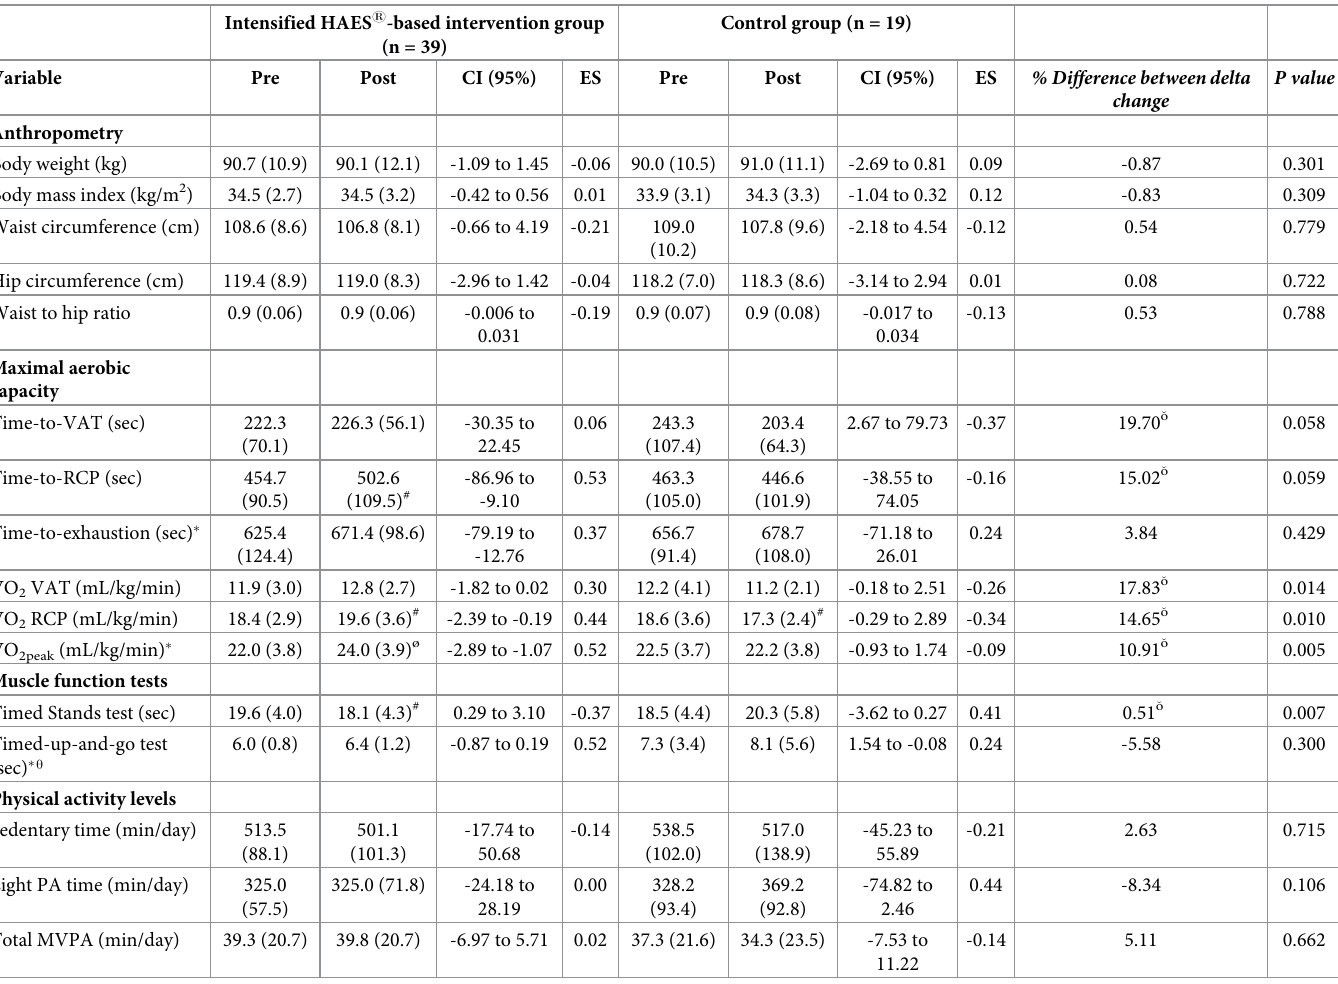
Table 4. Anthropometric, maximal aerobic capacity, muscle function, and physical activity assessments before and after the intervention. Intensified HAES 1 -based intervention group Control group (n = (n = 39)